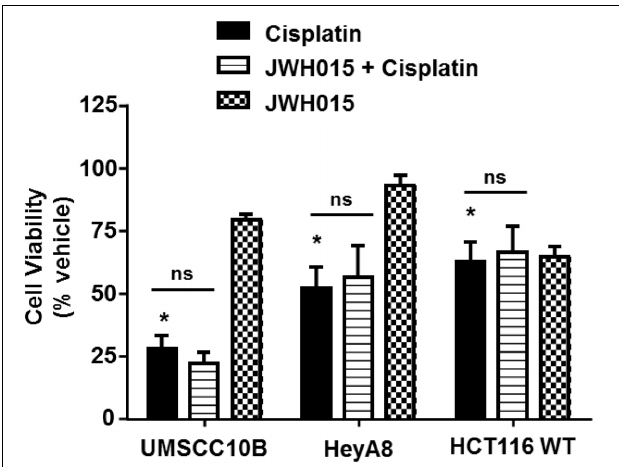
FIGURE 8 | Pre-treatment with JWH015 does not interfere with cisplatin anti-cancer efficacy in vitro . Different cancer cells (UMSCC10B, HeyA8, and HCT116 WT) were treated with JWH015 (10 µ M) for 30 min followed by cisplatin (10 µ M) for 48 h. The cell viability was measured by MTS assay. The percent cell viability is represented in the bar graph as mean ± SEM of at least four independent experiments. ∗ p < 0.05 represent significant difference from vehicle-treated group at 100% (one-way